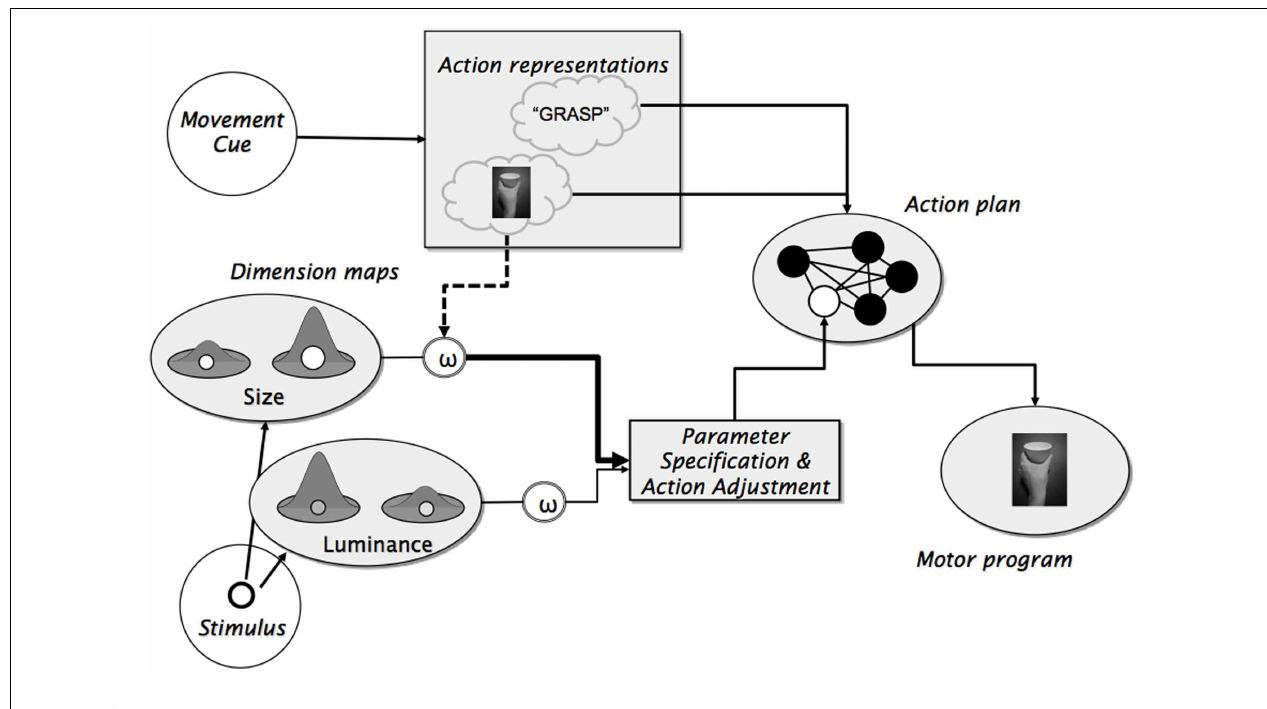
FIGURE 1 | Schematic representation of the idea that action planning not only determines the invariant aspects of an action but also biases attention toward feature dimensions